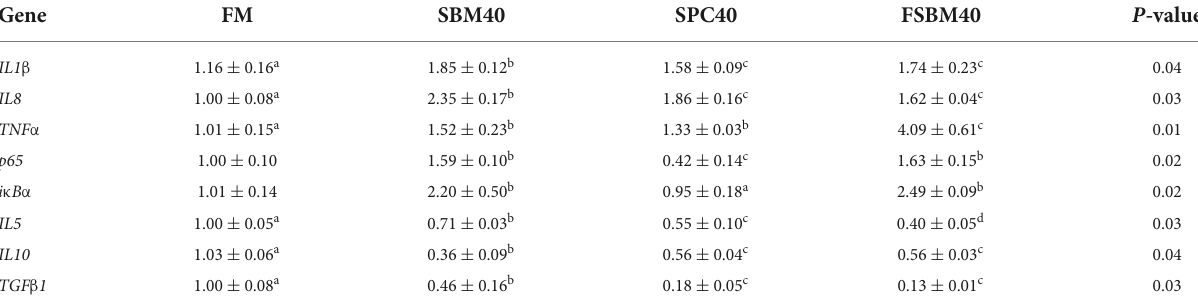
TABLE 7 Effect of different soy meals at 40% substitution levels for fish meal on the inflammatory-related gene expressions in hindgut of pearl gentian grouper ( n = 3). Gene